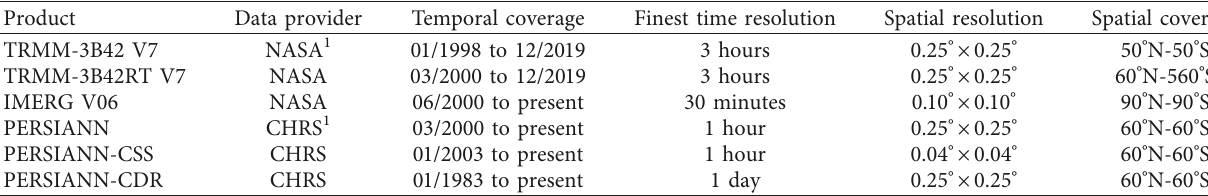
Table 2: Details of SRPs used in the